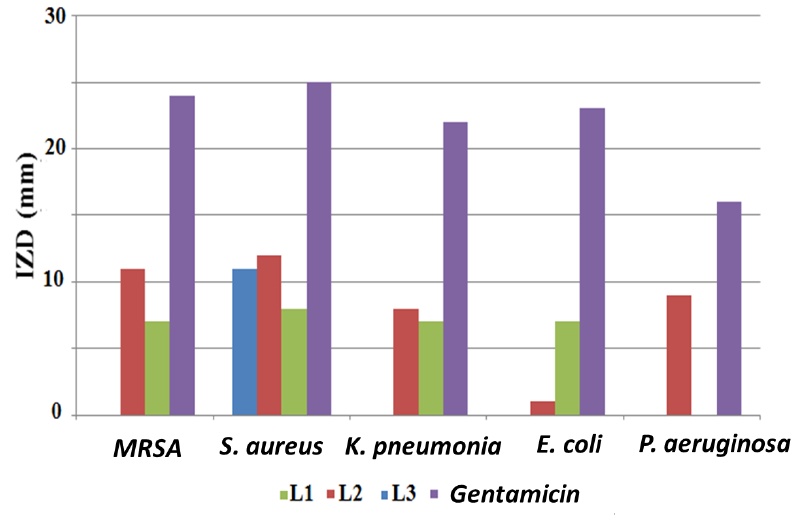
Figure 8. Antibacterial activity of ligands (1 mg/disk) using the agar disk diffusion method; (IZD) inhibition zone diameter.